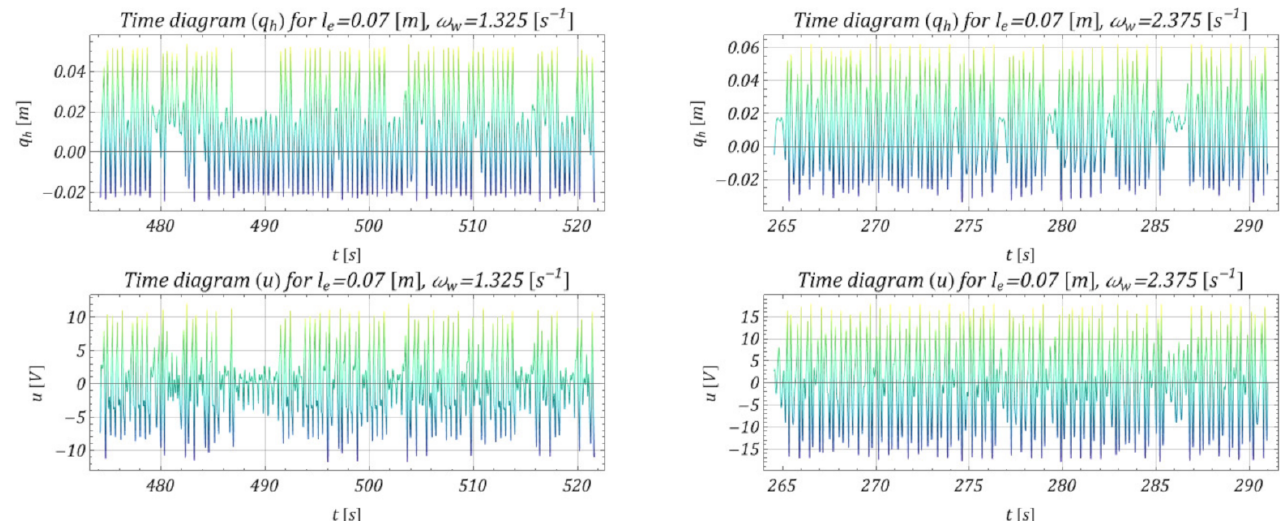
Figure 18. Voltage output and displacement time series related to selected solutions—sample chaotic solutions for l e = 0.07